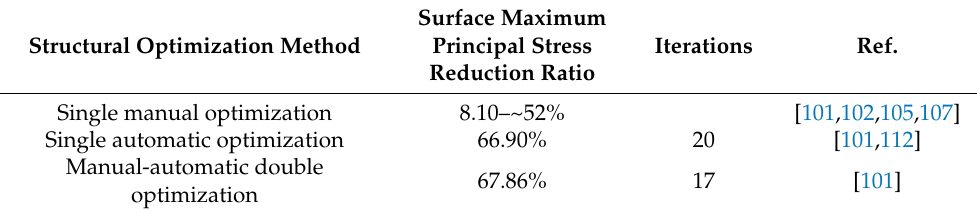
Table 2. Comparison of optimized data of claw-petal PET